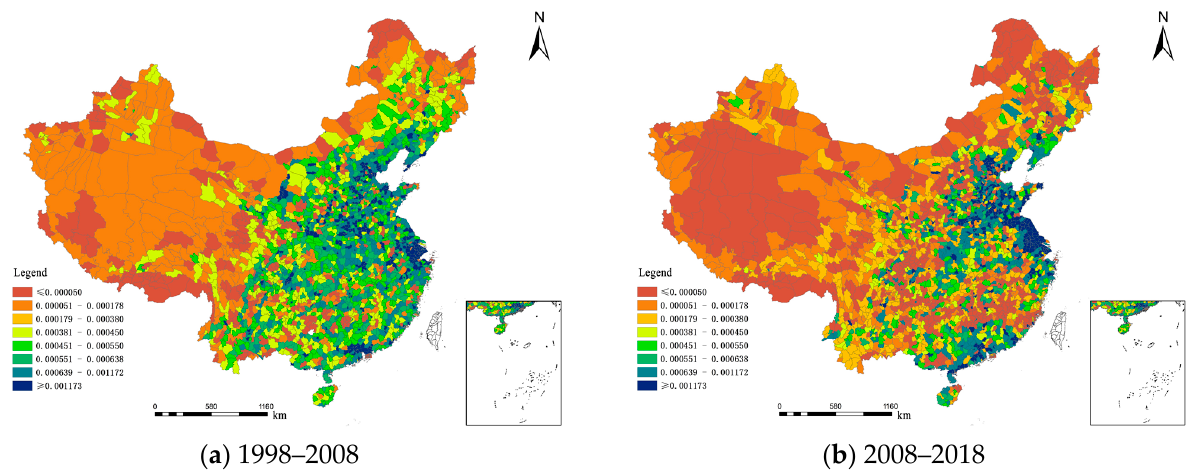
Figure 3. Changes in the land used for transportation at the county level in China from 1998 to 2018.